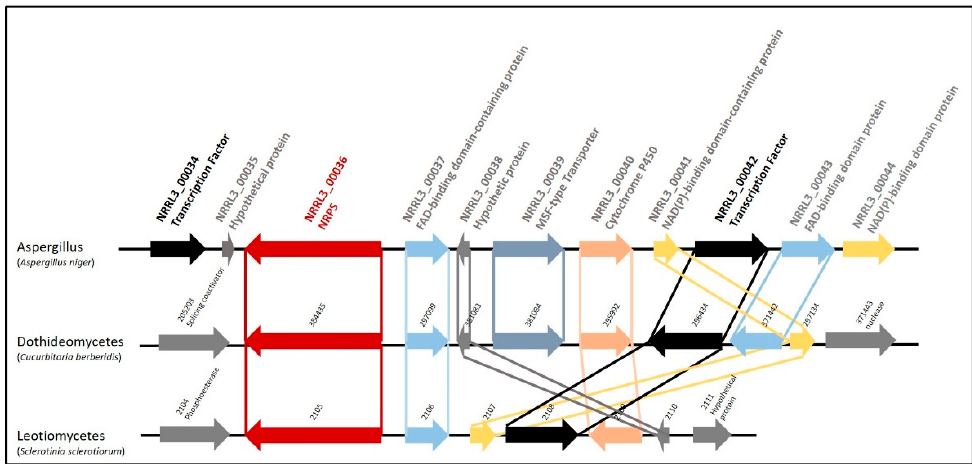
Figure 1. NRRL3_00036 biosynthetic gene cluster structure and synteny. Shown are organizations of the NRRL3_00036 cluster of Aspergillus (represented by A. niger ), Dithidiomycetes (represented by Cucurbitaria berberidis ) and Letiomycetes (represented by Sclerotinia sclerotiorum ).